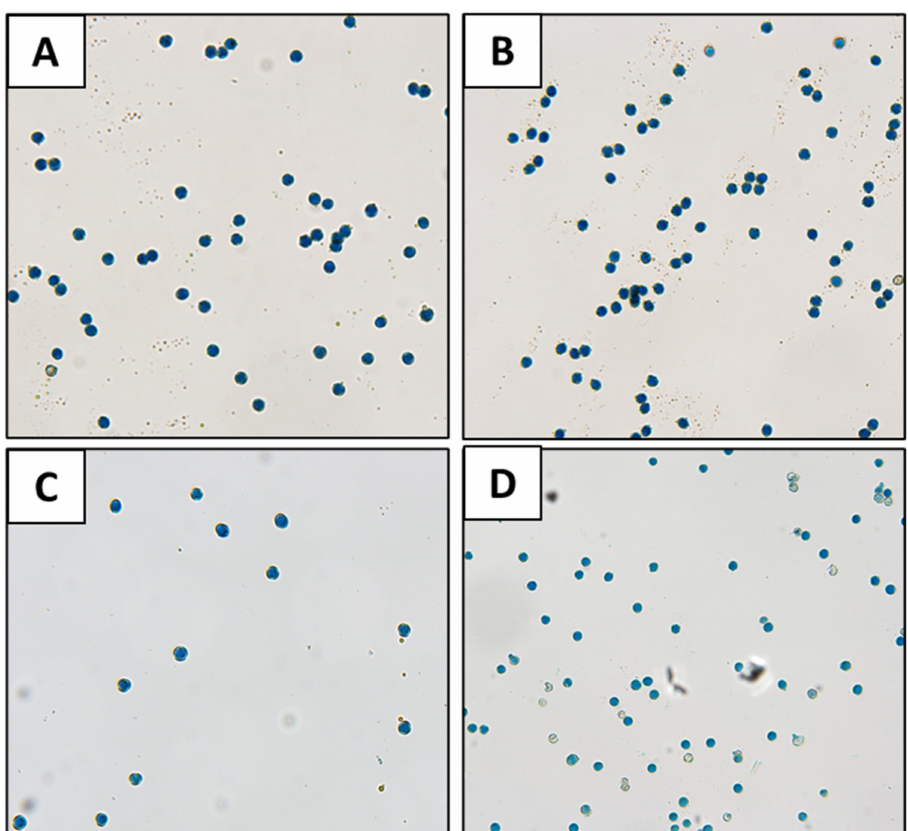
Figure 3. Stained pollen of Osmanthus armatus ‘Jim Porter’ ( A ), O. fortunei ( B ), O. fragrans ‘Fudingzhu’ ( C ), and O. heterophyllus ‘Kaori Hime’ ( D ). Fresh pollen was stained with modified Alexander’s stain and observed after 30 min at 10 × magnification using an Olympus BX-60 compound microscope with an Olympus Q Color 5 digital camera for image